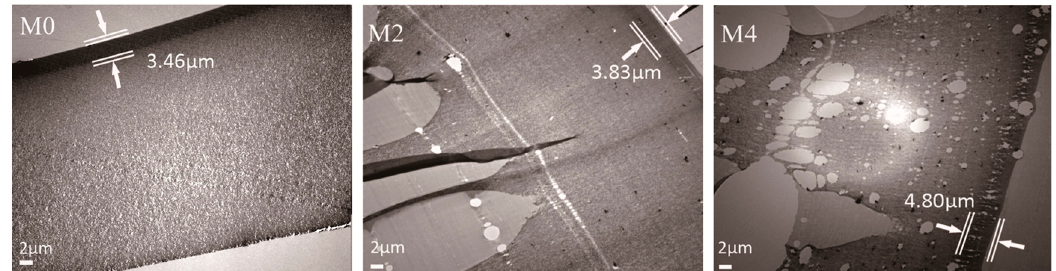
Figure 5. Cross-sectional TEM images of the M0, M2 and M4 membranes.